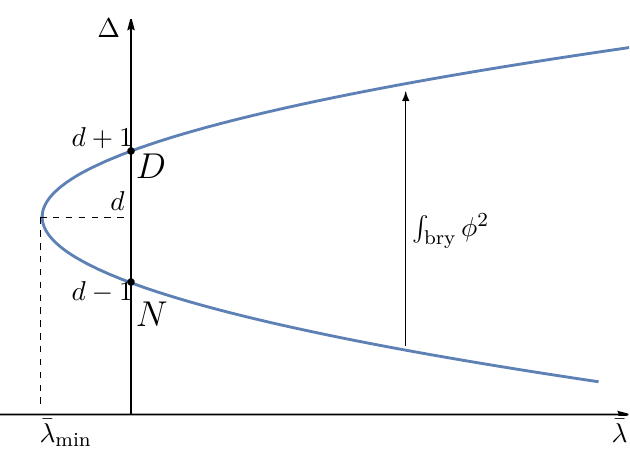
Figure 35. Scaling dimension of the first Z 2 -even boundary operator (above the identity) for a p free massive scalar field in AdS , namely ∆ = d ± 1 + 4¯ λ . The value ¯ λ = 0 corresponds to a d +1 conformally coupled scalar. The black dots mark the two possible BCFTs (Dirichlet or Neunmann and ∆ = d . There is boundary conditions). We see that the 2 curves merge smoothly at ¯ λ = − 1 4 also a ( Z preserving) boundary RG flow generated by the relevant boundary operator ( φ 2 ) with 2 ∆ < d that goes from the lower to the upper